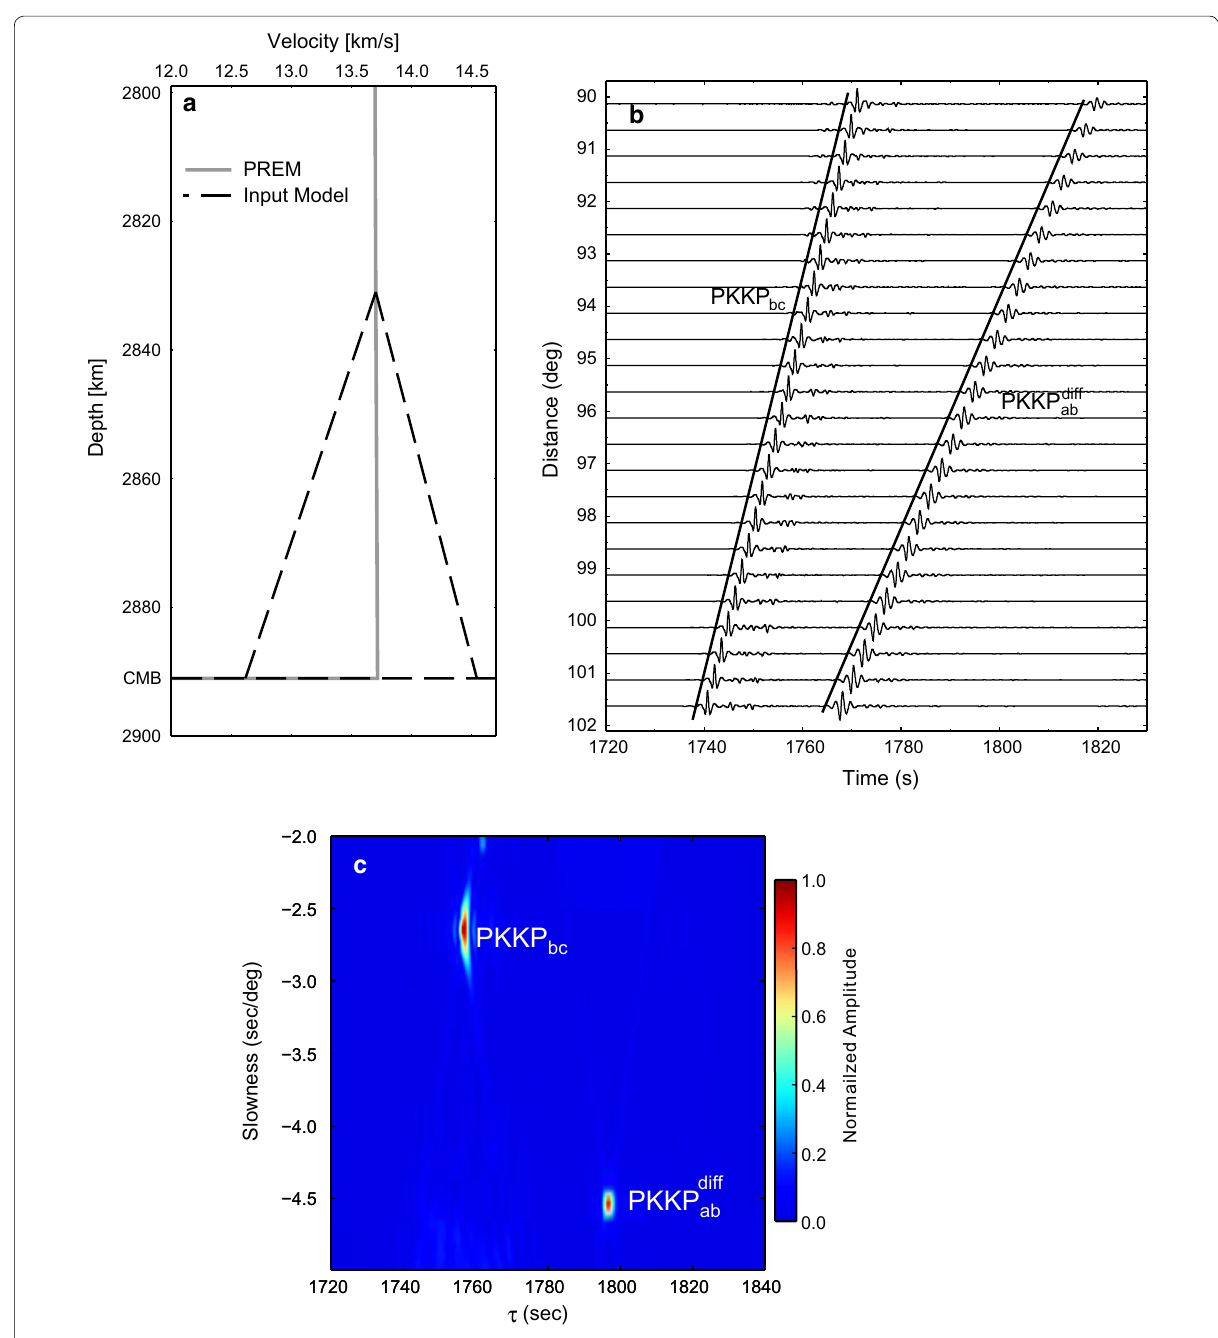
Fig. 4 a Models used in synthetic tests of RMT. Compared to PREM ( gray line ), the test model ( black line ) has either a P-wave velocity decrease from 0 to 8% (low velocity model) or an increase from 0 to 6% (high-velocity model) in a 60-km layer atop the CMB. b Synthetic seismograms calculated using DSM for a 500-km-depth event based on the low velocity model in a . The seismograms are band-pass filtered with the same frequency band as the observed data. The black lines denote the travel times of PKKP bc and PKKP ab diffraction waves, respectively. c Radon transform image of synthetic seismograms in b . The normalized amplitudes (shown in different color ) are energy of seismogram summations along their corresponding ray